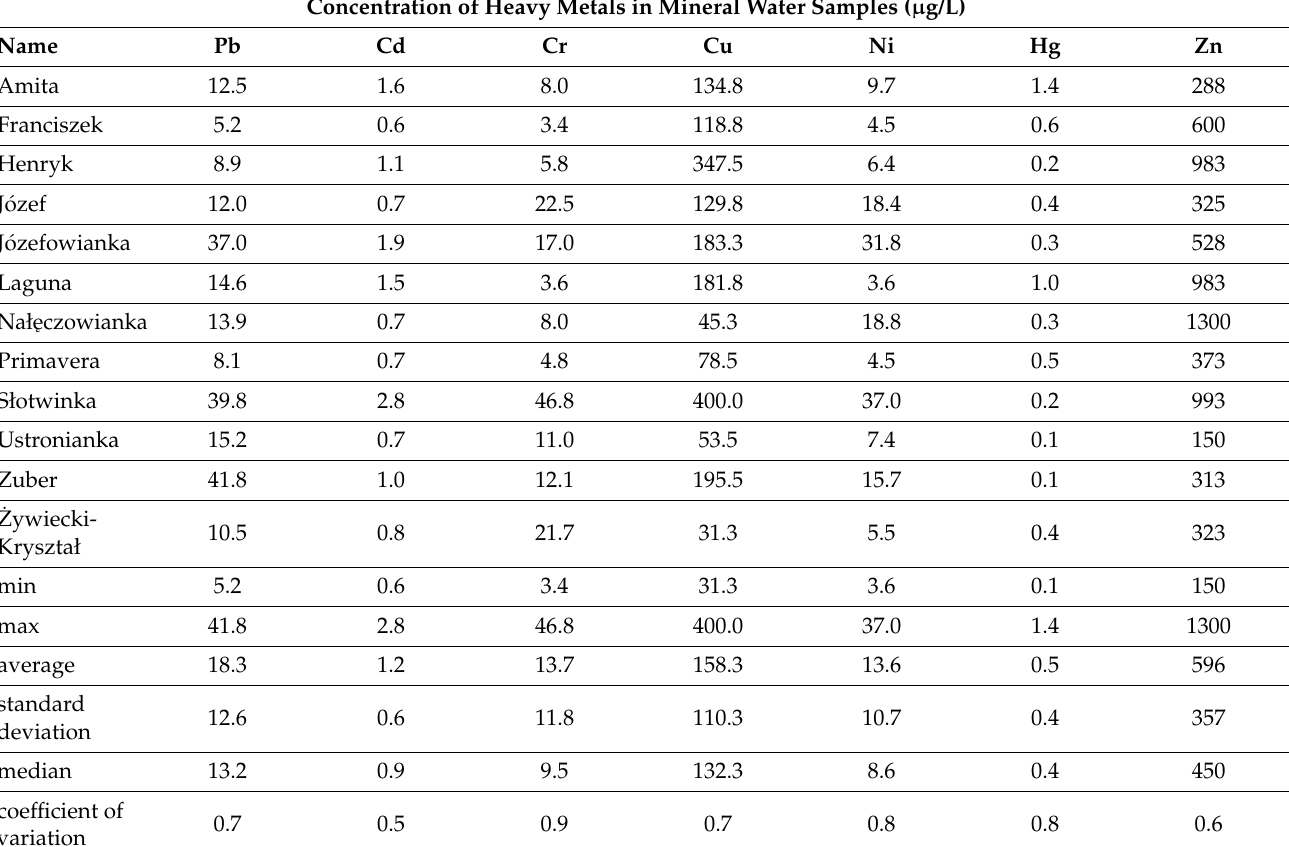
Table 6. The concentration of heavy metals in mineral water samples ( µ